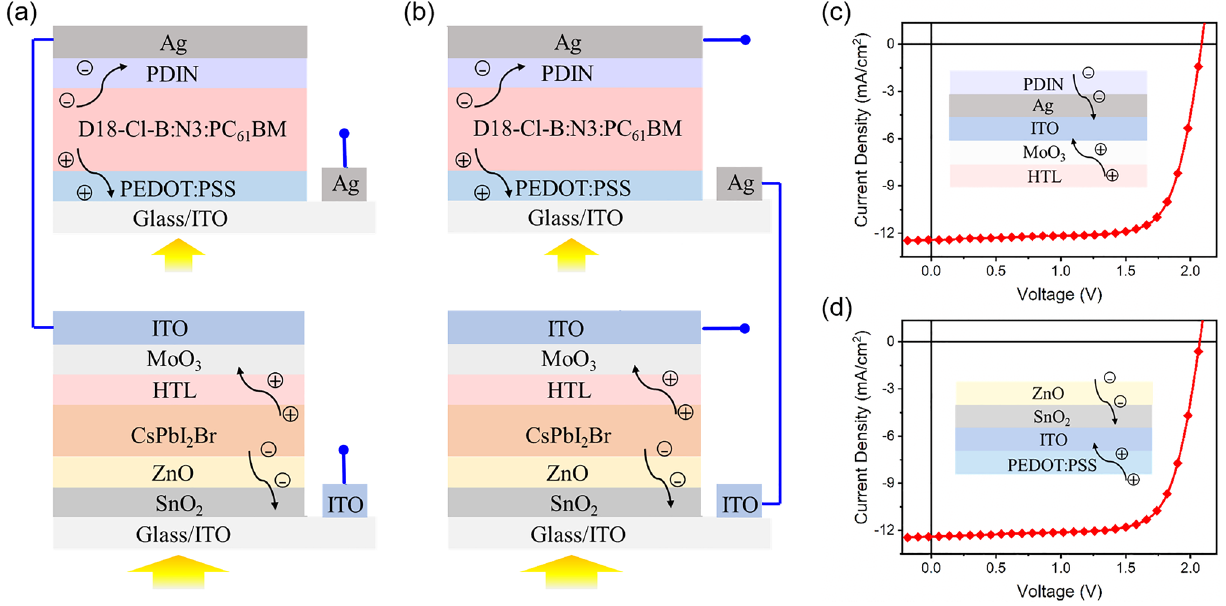
Fig. 3 a Structure for the 4-terminal perovskite/organic tandem solar cells. b J–V curves for the best semi-transparent PSC (top cell), stand- alone OSC, and filtered OSC (bottom cell). c EQE spectra for the semi-transparent PSC, stand-alone OSC, and filtered OSC. The dash line is the sum of the EQE for the PSC and filtered OSC